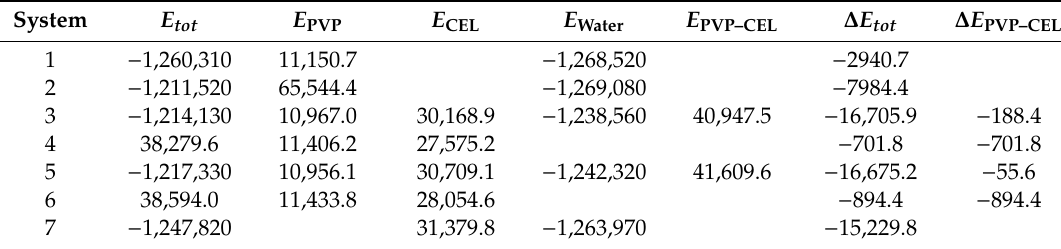
Table 3. Total energies of the systems ( E tot ), single point energies of the components and